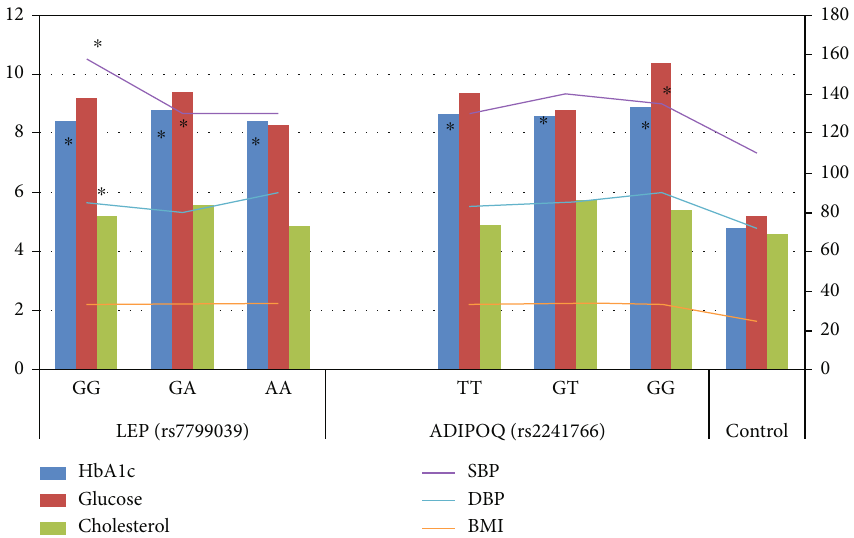
Figure 1: The clinical symptoms of MS for the LEP (rs7799039) and ADIPOQ (rs2241766) gene polymorphisms. HbA1c: glycated hemoglobin (%); glucose: fasting plasma glucose level (mmol/L); cholesterol: plasma level of cholesterol (mmol/L); SBP: systolic blood pressure (mmHg); DBP: diastolic blood pressure (mmHg); BMI: body mass index (kg/m 2 ). ∗ p < 0 : 05 MS vs.